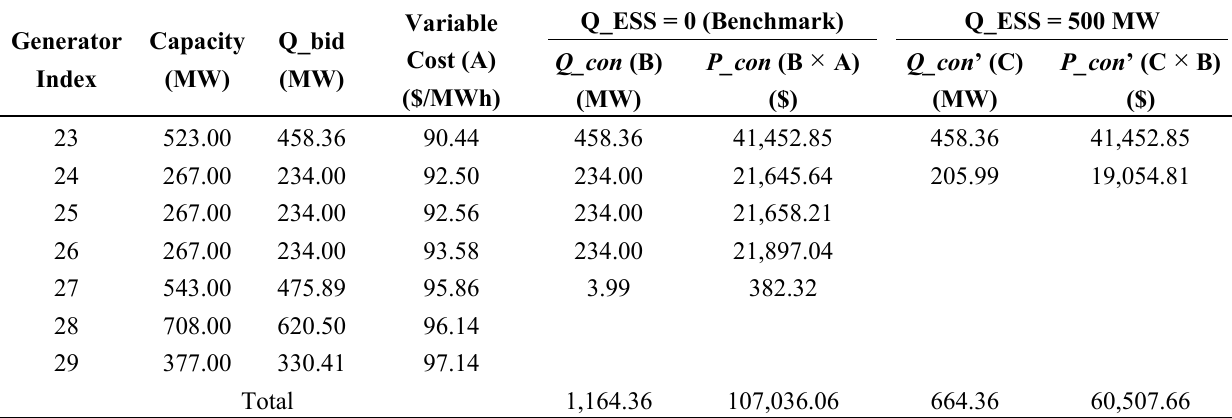
Figure 3. Calculating Q_con (i)’. Table 2. Example of calculating Q_con and Q_con